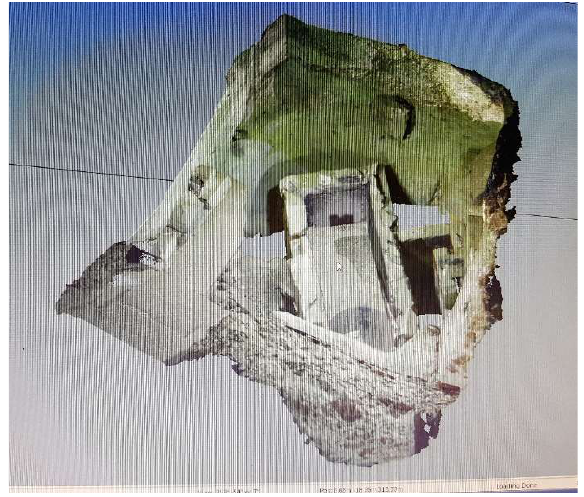
Figure 15. 3D Printing process of Ipi’s sarcophagus chamber